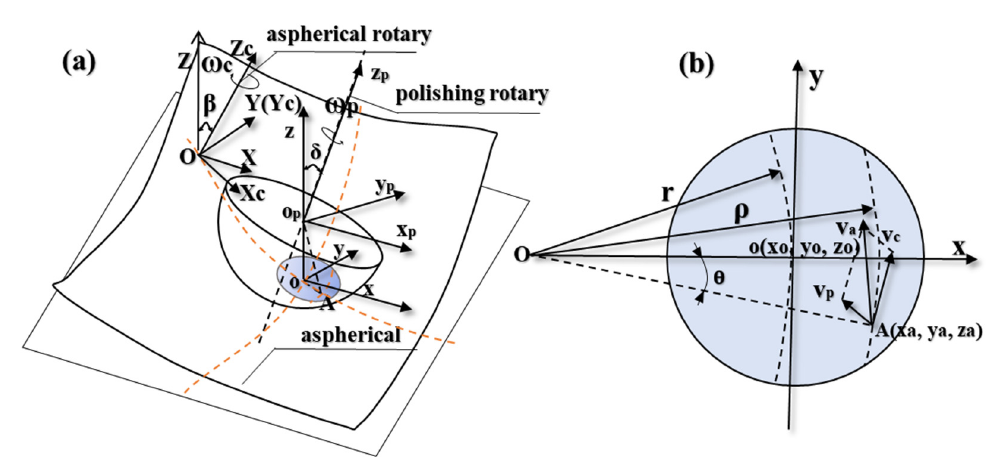
Figure 1. ( a ) Schematic diagram of spherical polishing tool; ( b ) Schematic diagram of the relative line speed distribution in the contact region.